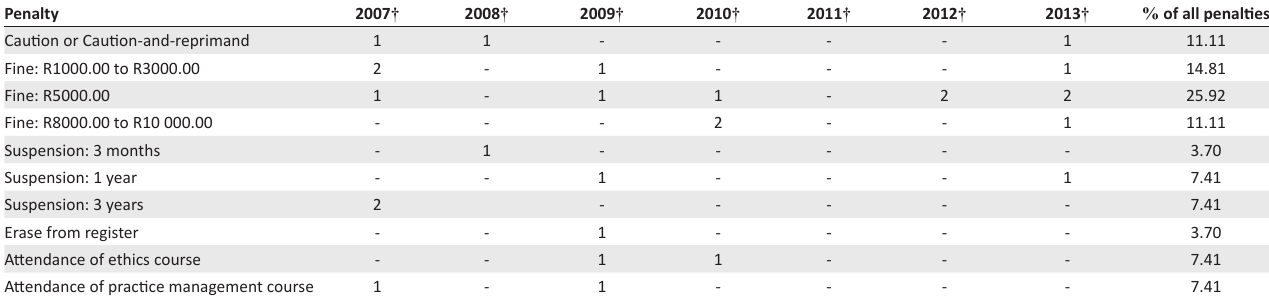
TABLE 2: Annual frequency of penalties imposed on sanctioned physiotherapists